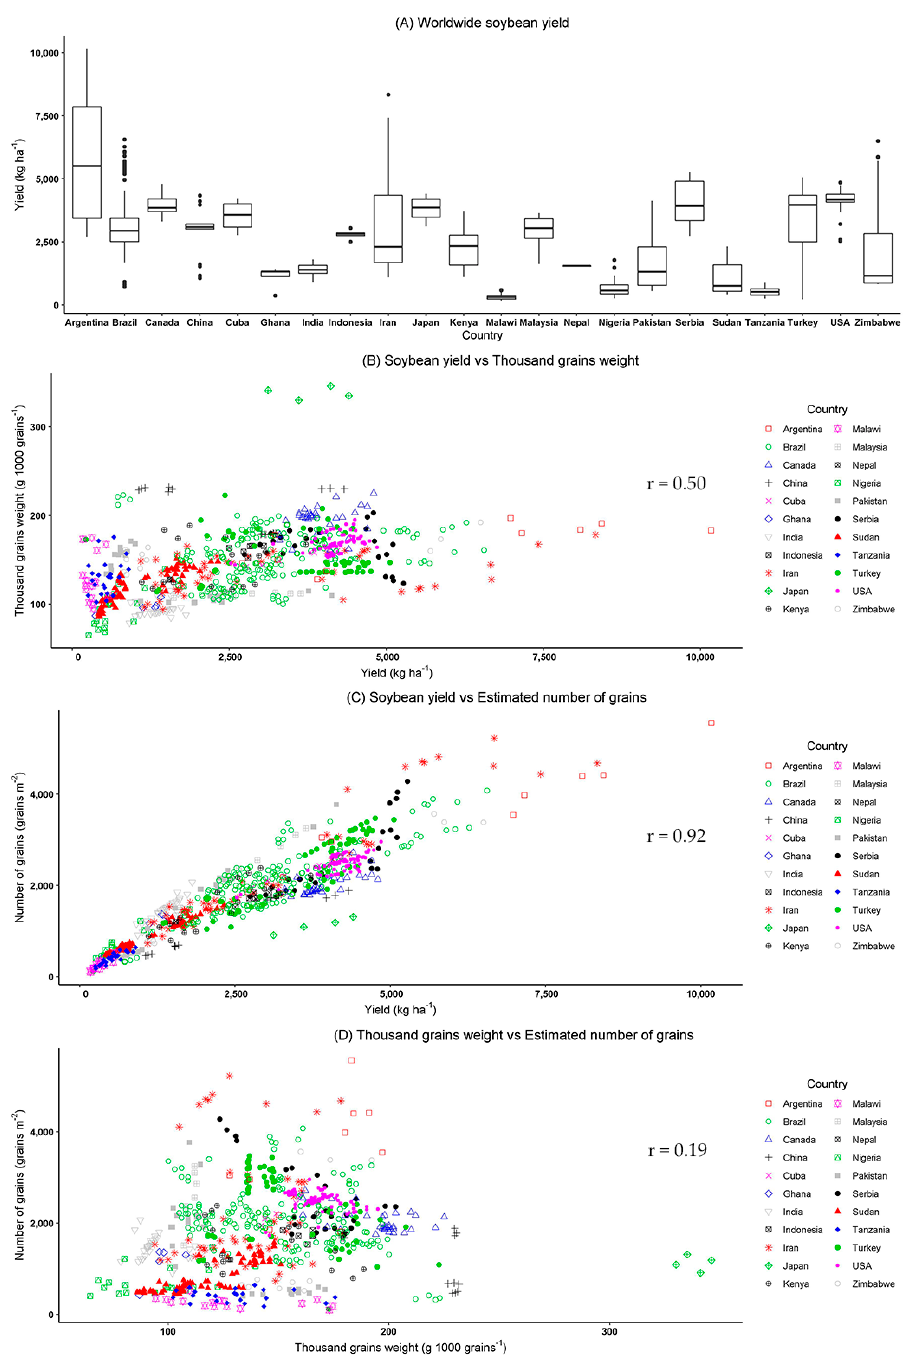
Figure 1. Boxplot and scatterplots of observed soybean yield (kg ha − 1 ) and its yield components by country. ( A ) Worldwide soybean yield (kg ha − 1 ) by country, ( B ) thousand grains weight (g 1000 grains − 1 ), ( C ) number of grains (grains m − 2 ) and ( D ) thousand grains weight (g 1000 grains − 1 ) versus number of grains (grains m − 2 ). r = correlation coe ffi